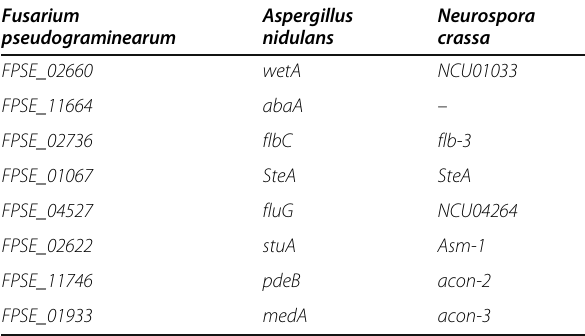
Table 1 Homologous genes related to conidiation among Aspergillus nidulans , Neurospora crassa and Fusarium pseudograminearum Fusarium pseudograminearum